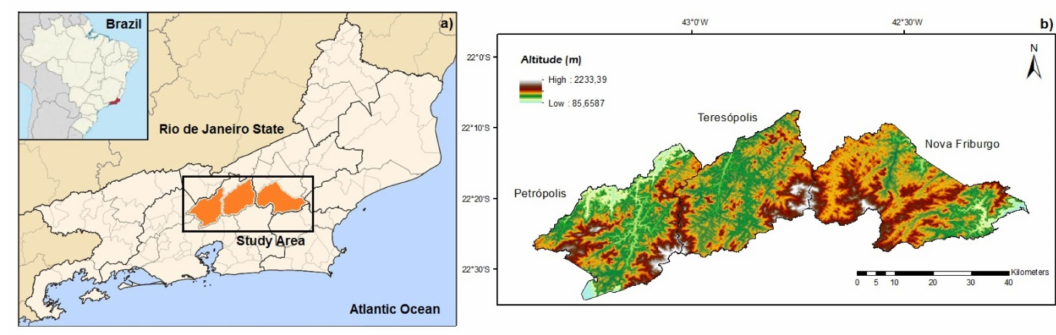
Figure 1. Study area location ( a ) and its elevation map ( b